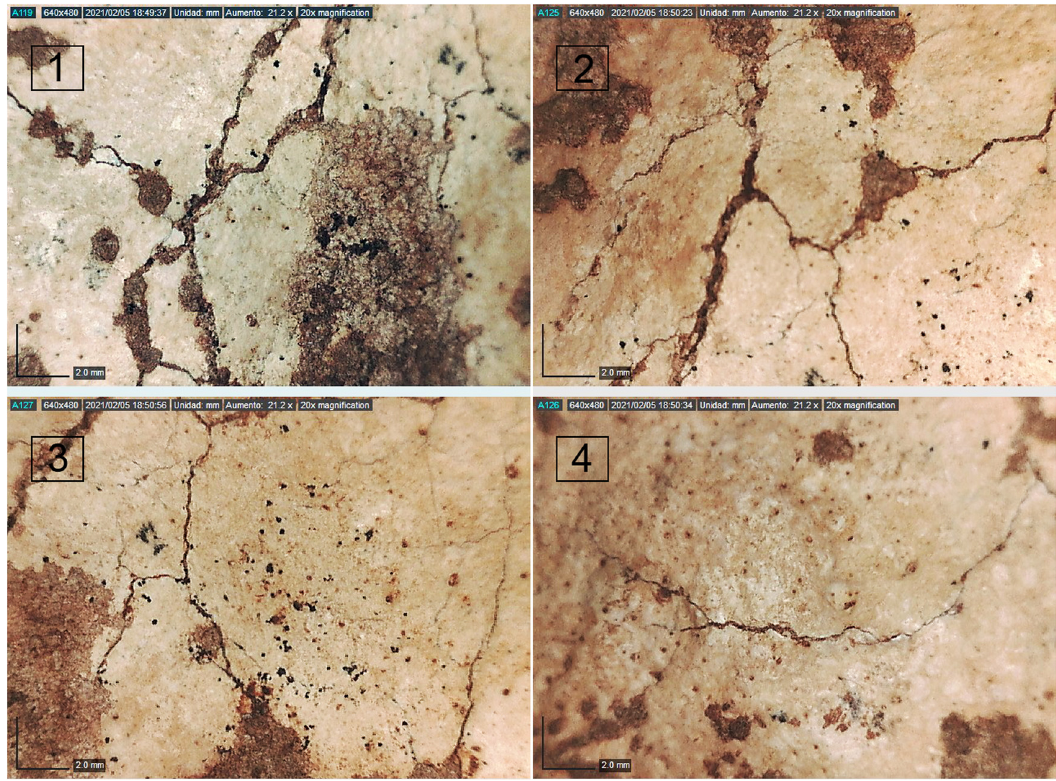
Figure 6: Four di ff erent views of the exterior cranial surface in the frontal bone 7001 ( 640 × 480 pixels Dinolite, 1 mm scale ) . 1 – 4: micro - cracks extended over the bone cortex; 1 – 3: black dots ( probably manganese dioxide staining ) ; 1 and 4: slightly bright over the frontal